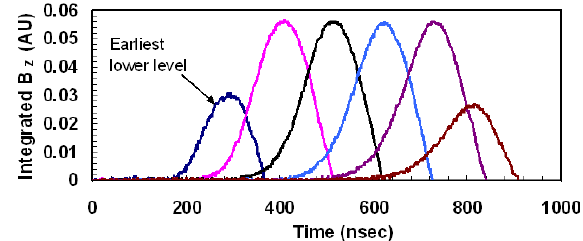
FIG. 2. (Color) Low voltage test of pulse propagation measured with a B-dot loop at 20.3 cm intervals. The earliest lower level signal is near the primary strap and the last signal is midway through the resistive termination string.